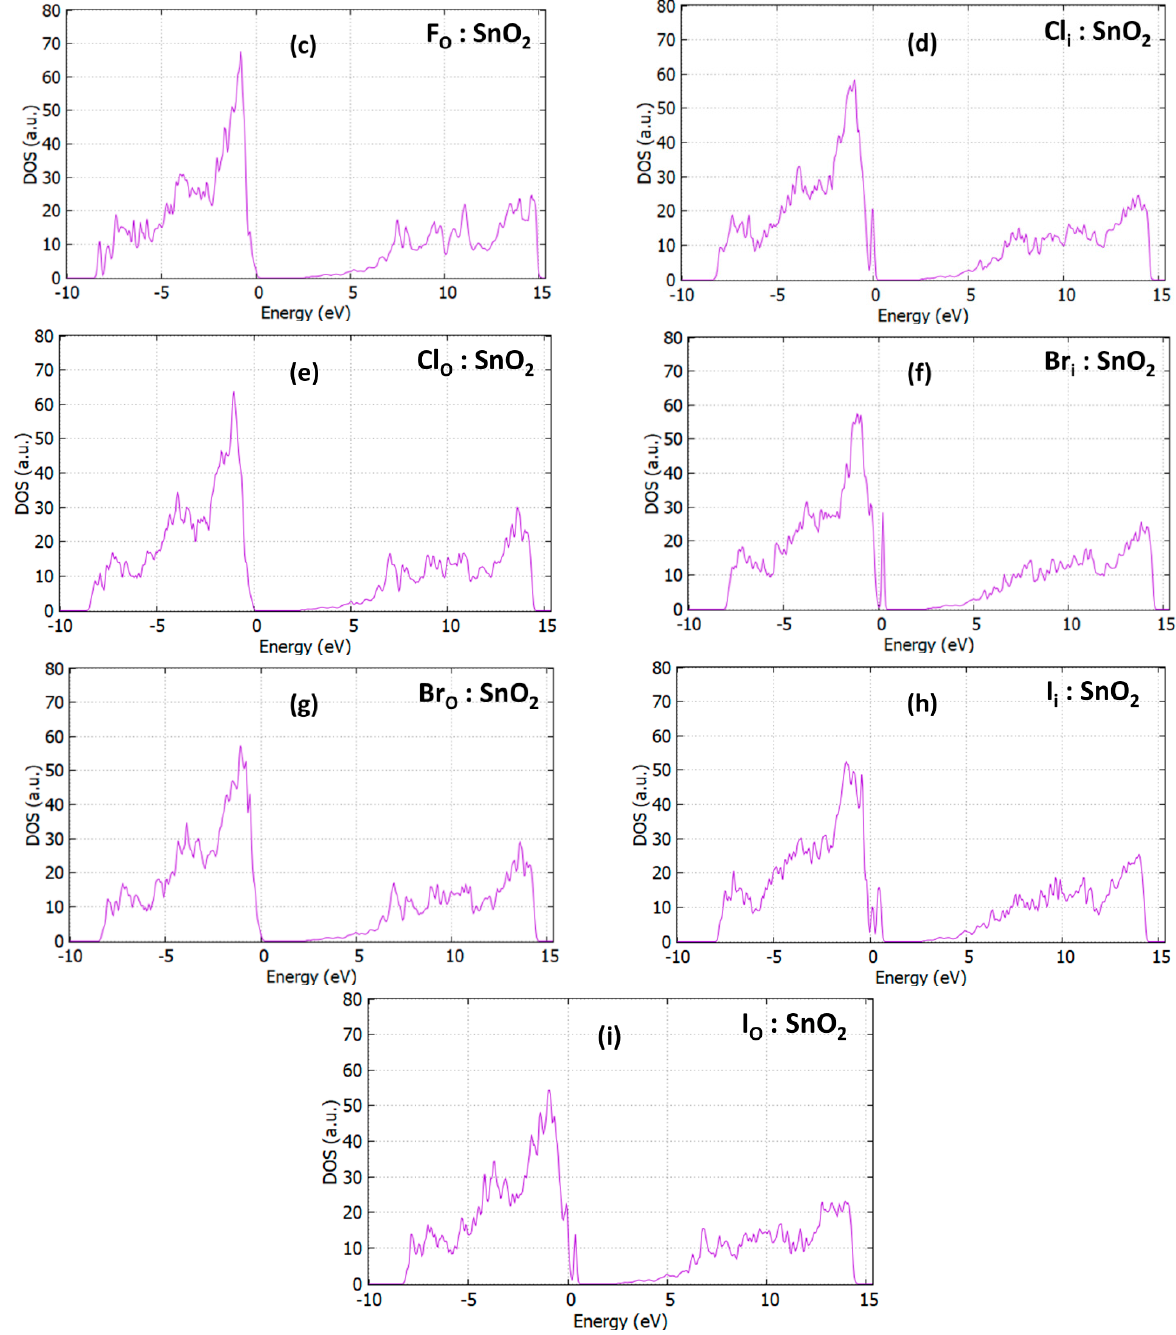
Figure 2. The Density of States (DOS) of the ( a ) undoped SnO 2 , ( b ) F i doped SnO 2 , ( c ) Fo doped SnO 2 , ( d ) Cl i doped SnO 2 , ( e ) Clo doped SnO 2 , ( f ) Br i doped SnO 2 , ( g ) Br O doped SnO 2 , ( h ) I i doped SnO 2 , and ( i ) I O doped SnO 2.